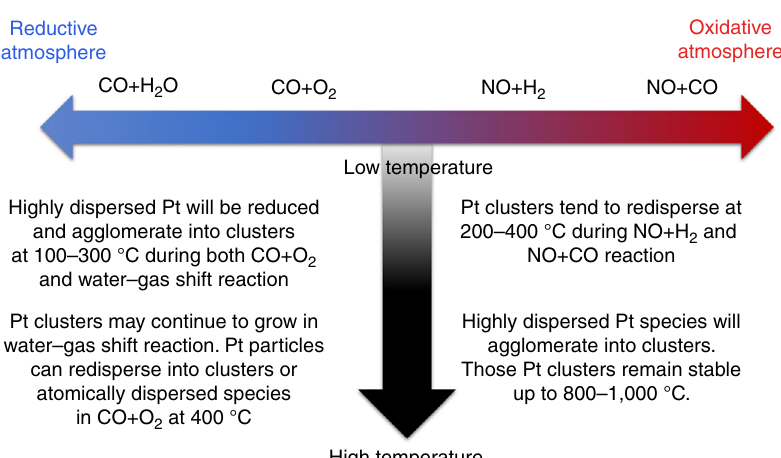
Fig. 8 Comparison of the evolution of Pt species under different reaction conditions. The evolution of subnanometric Pt species is related with the reactants and